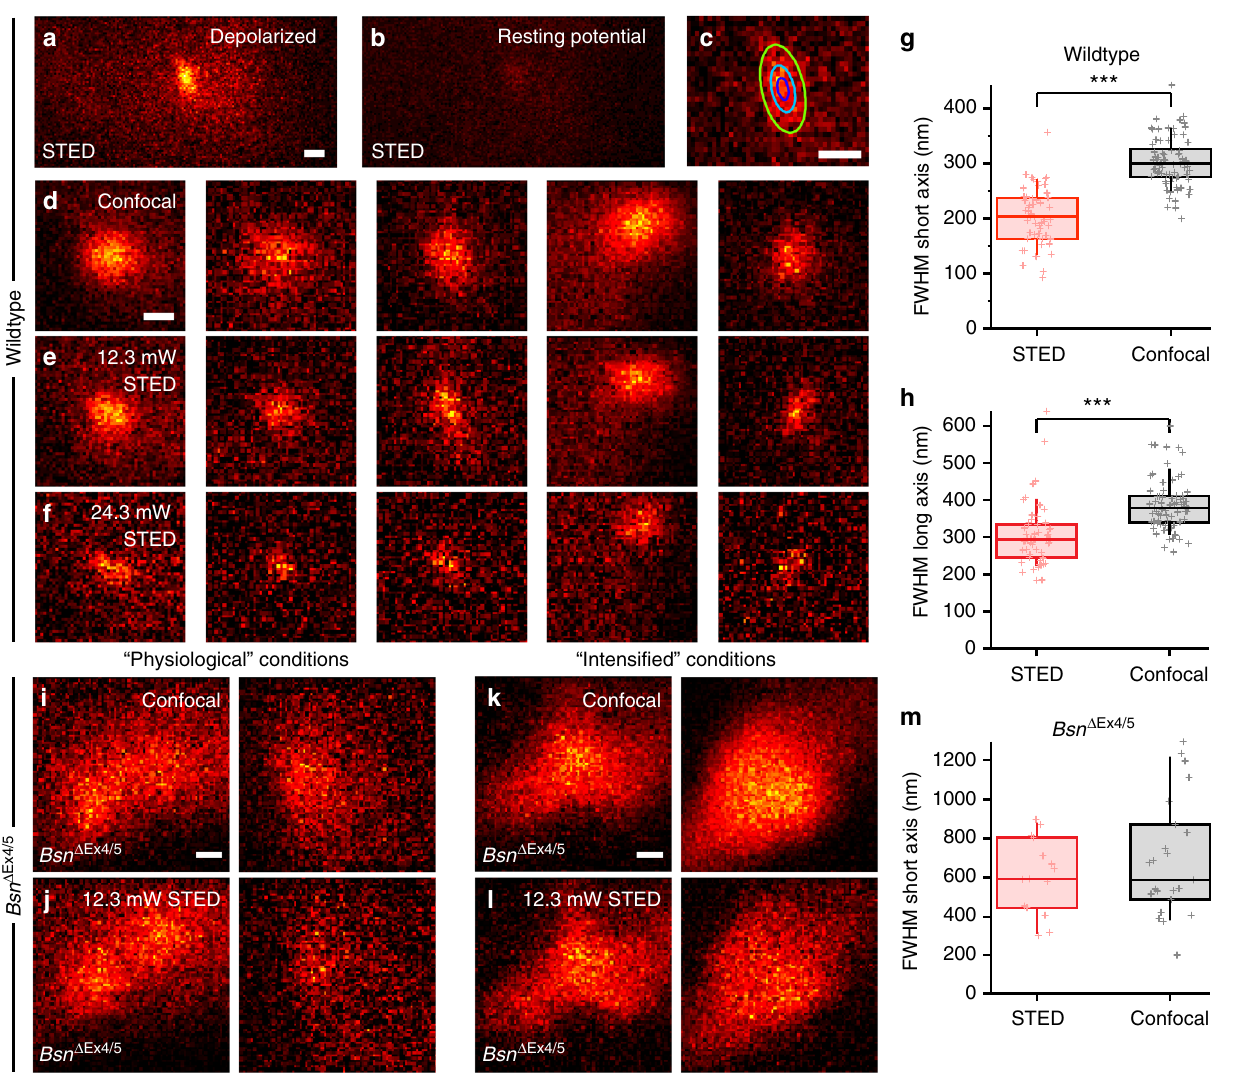
Fig. 6 Super-resolution imaging of presynaptic Ca 2+ signals in IHCs. a – c Hotspot of OGB-5N fl uorescence in a wildtype mouse IHC in “ physiological conditions ” (same in d – f , 25 µ M OGB-5N, 0.8 mM EGTA, and 0.4 mM BAPTA inside the pipette, 1.3 mM [Ca 2+ ] e ), evoked by a 78-ms depolarization of the cell to − 14 mV ( a ), as well as the corresponding fl uorescence signal at the holding potential of − 84 mV ( b ), both imaged using STED. c A 2D Gaussian fi t to the background-subtracted hotspot image. Scale bars: 200 nm. d – f Background-subtracted images of depolarization-evoked hotspots of OGB-5N fl uorescence, indicating synaptic Ca 2+ in fl ux, each imaged in confocal mode ( d ), with 12.3 mW STED laser intensity ( e ), and with 24.3 mW STED laser intensity ( f ). Increasing STED power leads to smaller and more elongated hotspots. Scale bar: 200 nm. g , h Signi fi cantly increased resolution of Ca 2+ imaging by STED microscopy: the dimensions of the Ca 2+ domains were measured by fi tting a 2D Gaussian function to the background-subtracted images. Both short ( g ) and long axis ( h ) of the Gaussian were signi fi cantly smaller when measured with STED microscopy (red, n = 55 synapses, N = 43 IHCs, STED power 12.3 – 35 mW) compared to confocal microscopy (black, n = 74 synapses, N = 55 IHCs) with p = 1.7e − 21 for g , Student ’ s T -test, statistical power: 1, and p = 3.3e − 11 for h , Mann – Whitney U test, statistical power: 1. i , j Background-subtracted images of two representative depolarization-evoked hotspots of fl uorescence from Bsn Δ Ex4/5 mouse IHCs, imaged in “ physiological conditions ” (see a – c ) in confocal mode ( i ) and with 12.3 mW STED power ( j ). The hotspots are much larger than those from wildtype animals ( a – h ) and do not decrease in size when using STED microscopy. Scale bar: 200 nm. k , l Same as in i , j , but imaged in “ intensi fi ed conditions ” (300 µ M OGB-5N and 10 mM EGTA inside the pipette, 10 mM [Ca 2+ ] e ). m The size of hotspots of Bsn Δ Ex4/5 mice (as measured by fi tting of a 2D Gaussian function) is unchanged when using STED (red, n = 15 synapses, N = 13 IHCs, STED power 12.3 – 24.3 mW) compared to confocal recordings (black, n = 23 synapses, N = 21 IHCs), with p = 0.605, Mann – Whitney U test, statistical power: